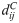
The Canberra distances dijC toward the USA versus time, for each of the 11 countries analyzed, t ∈ [1960, 2015], and weights αk={73,13,13}.The clusters C1 = {AUS, CAN, CHE, FRA, GBR, JPN, USA} and C2 = {BRA, CHN, IND, MEX, ZAF} are visible.